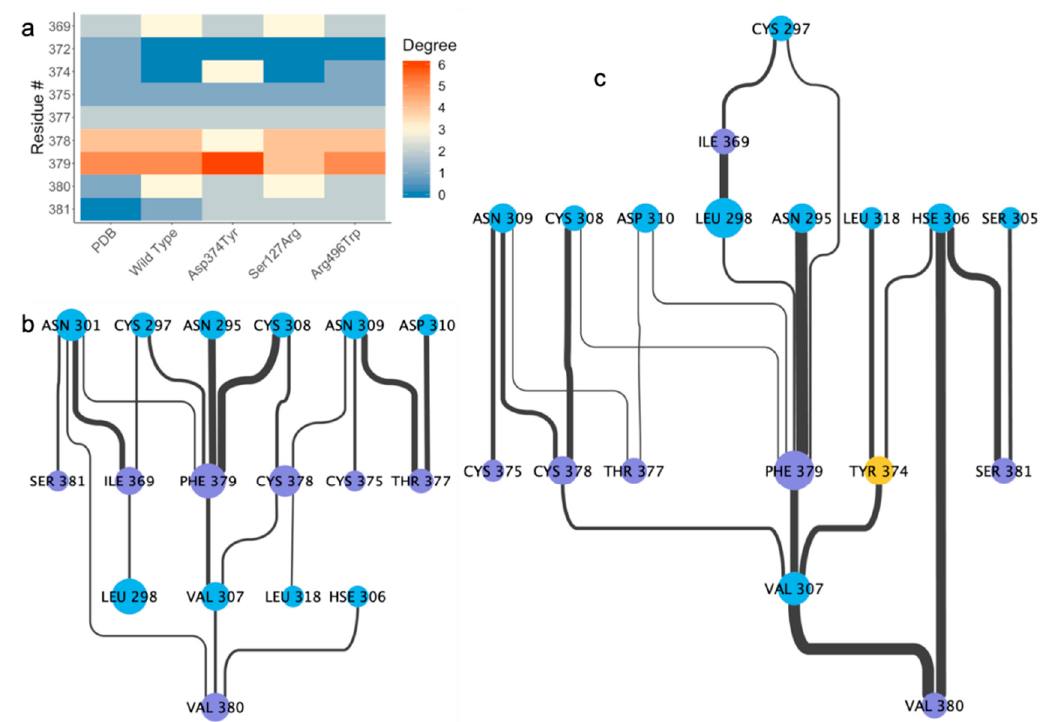
Figure 4. Contacting residues in the catalytic domain of PCSK9. ( a ) Number of contacts (degree) of residues in PCSK9 along the crystallized interface of the catalytic domain of PCSK9 and EGF(A) in LDLR. Residue interaction network for the interface between the catalytic domain of PCSK9 and LDLR in the ( b ) wild-type and ( c ) Asp374Tyr systems.